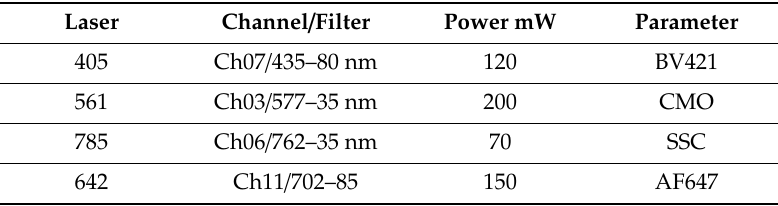
Table 3. Settings used for